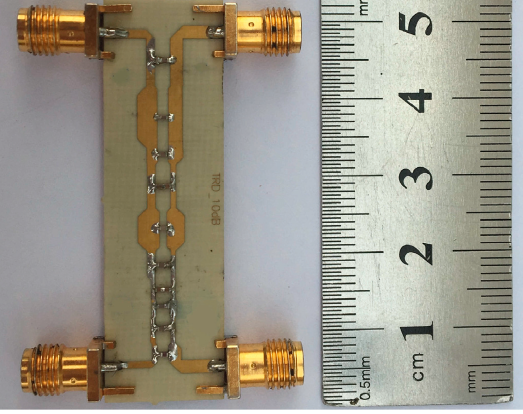
Figure 15: Fabricated 10dB ATRD coupler of Example